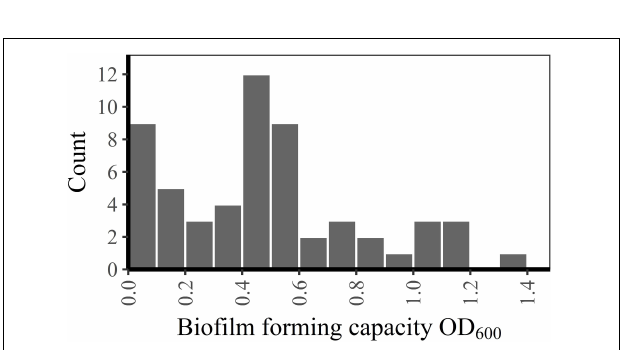
FIGURE 2 | Frequency distribution of biofilm forming